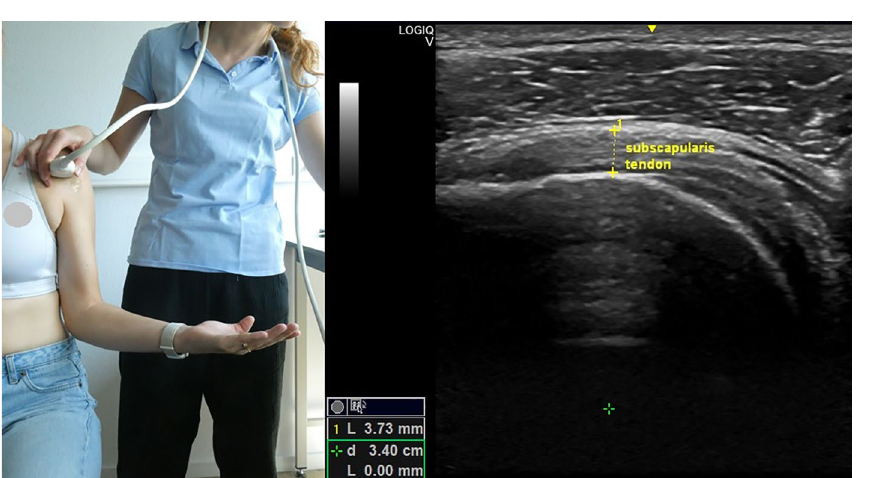
Figure 3. Left: position of the probe and of the subject during the measurement of the subscapularis tendon thickness; right: measurement of the subscapularis tendon thickness. Photo on the left side by Anthe